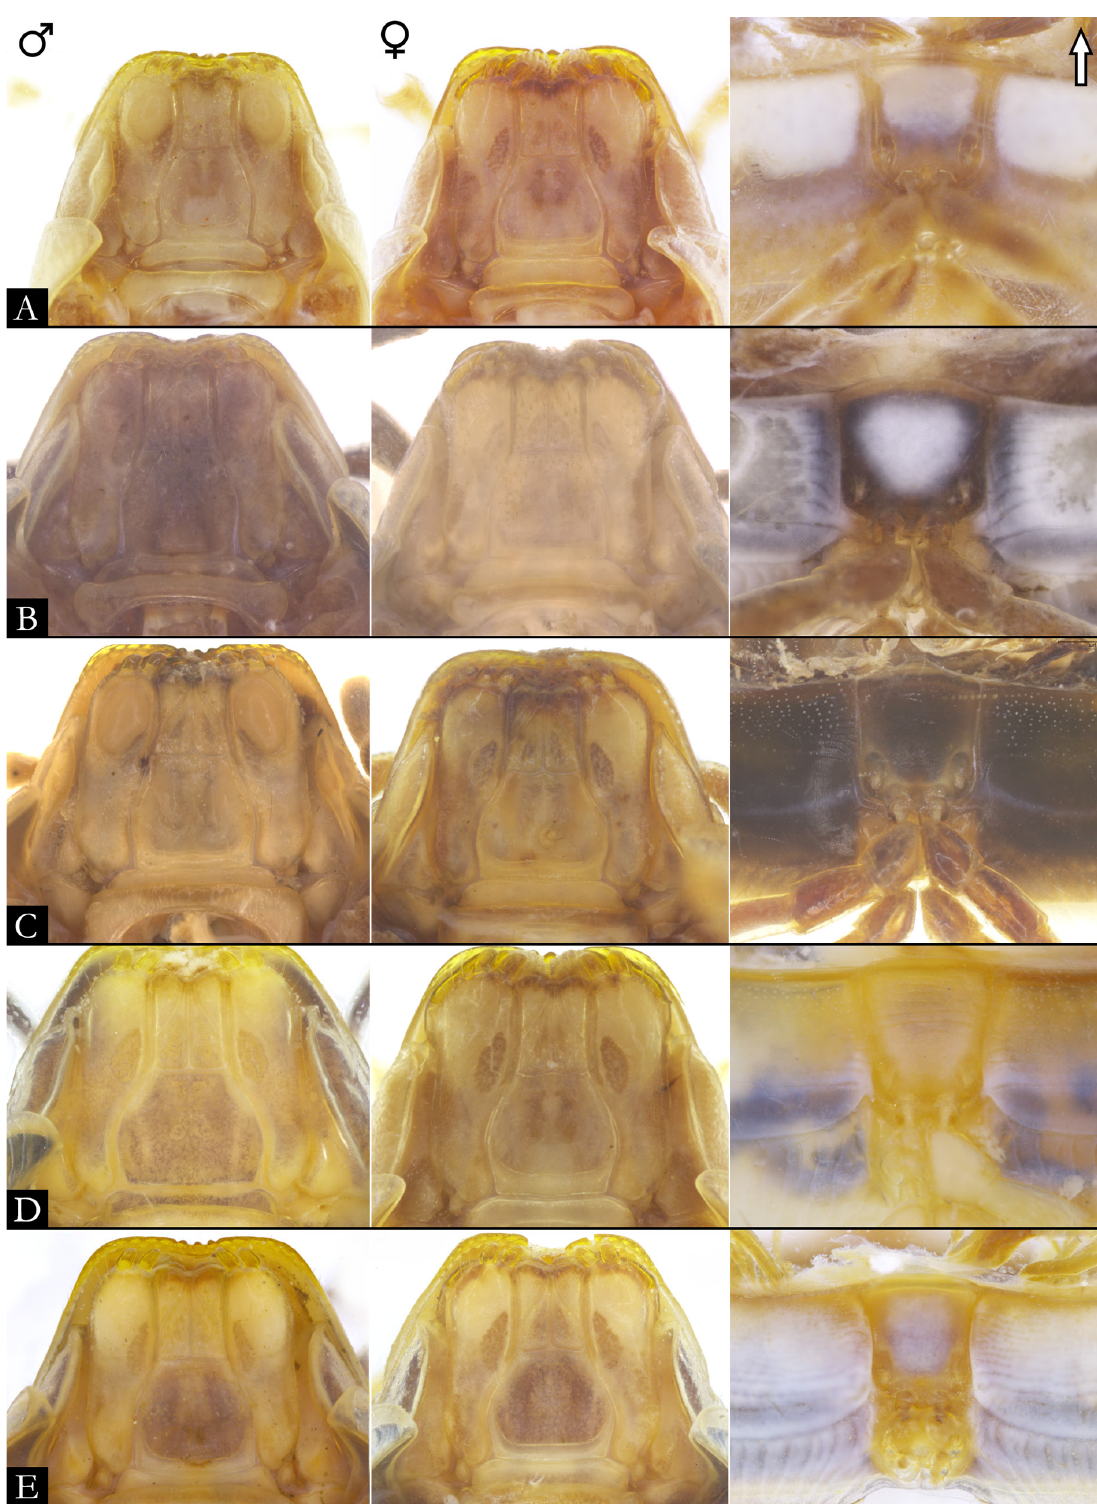
Fig. 170. Stereoscopic images of gnathochilarium and anterior sternum of species of